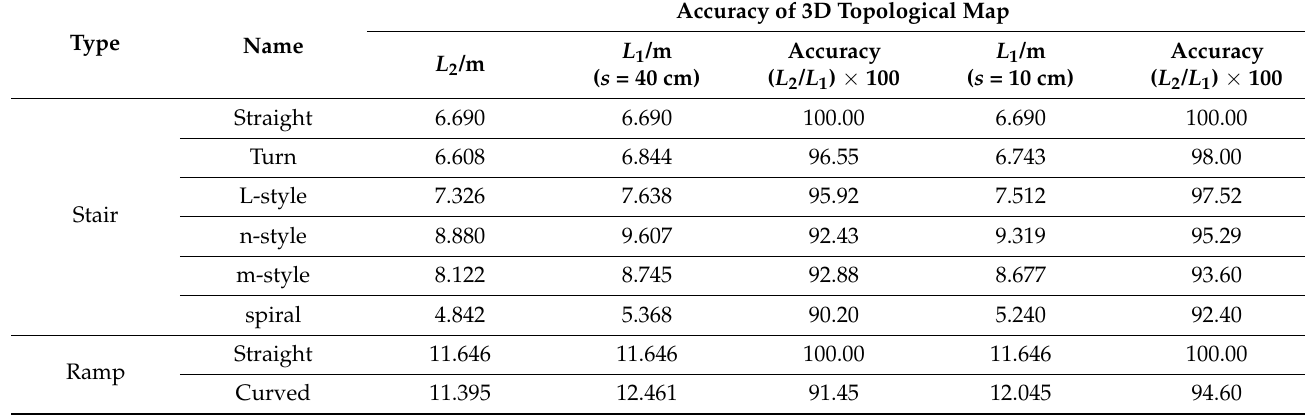
Table 1. Accuracy of the cross-floor path